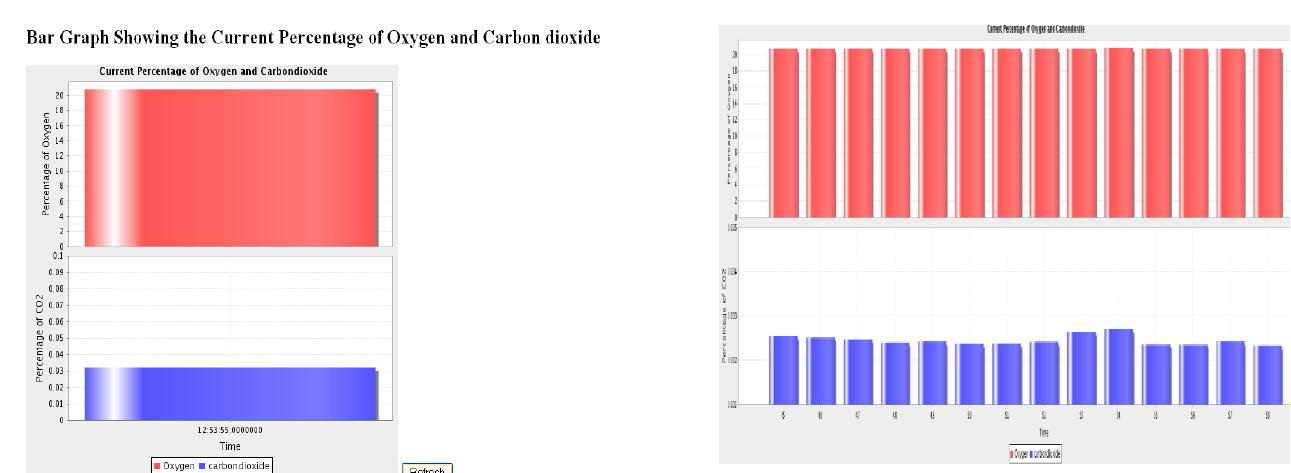
Figure 6. Phase – II Flowchart showing the steps involved in providing observation Services to the end user